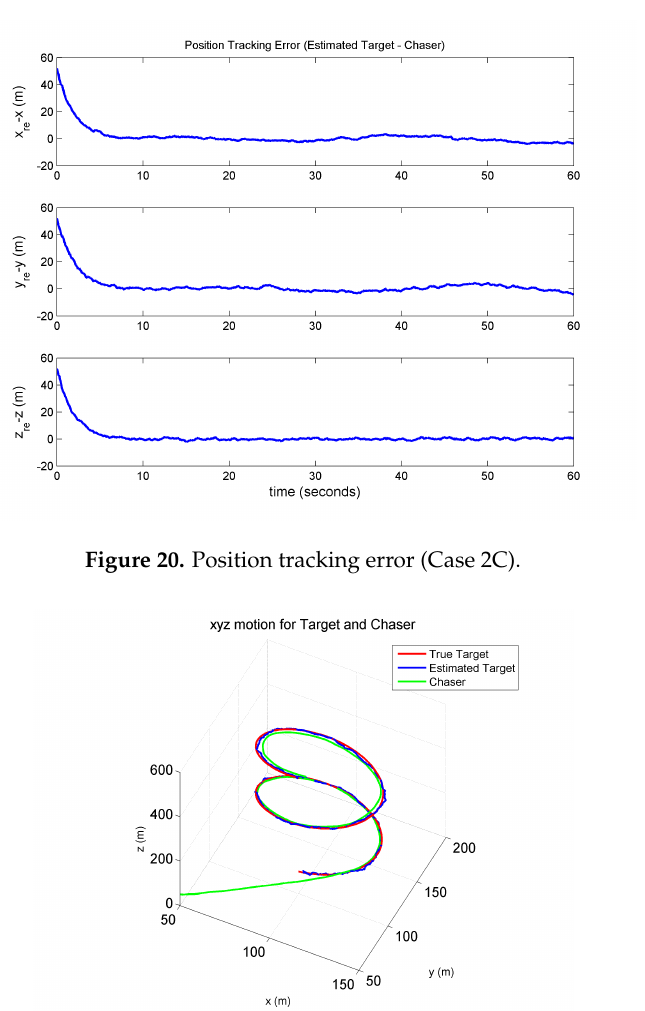
Figure 21. Chaser trajectory while tracking the estimated target (Case